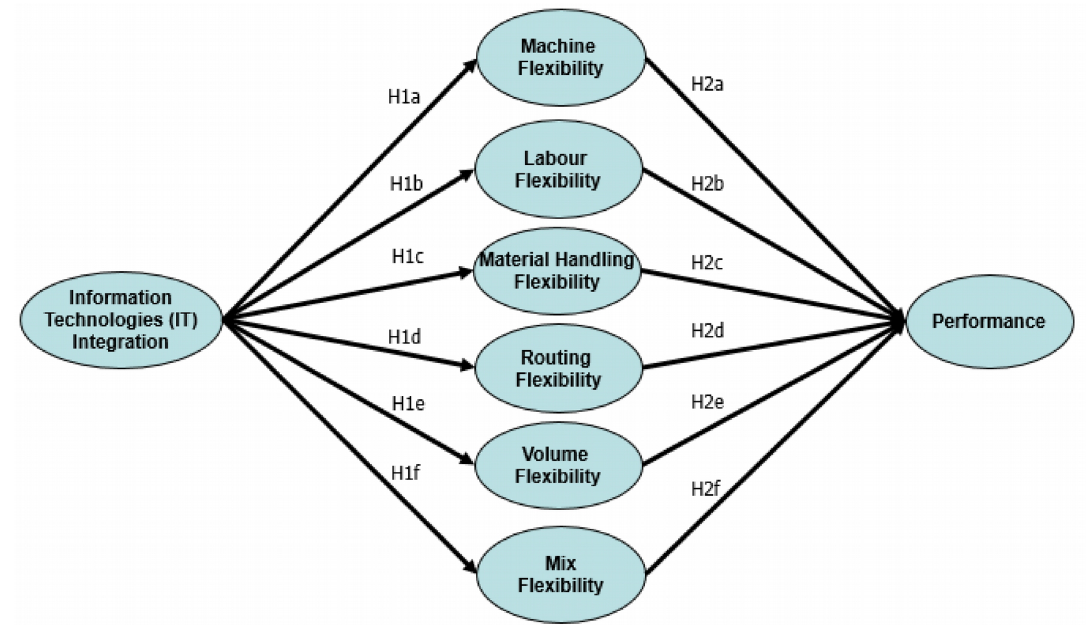
Figure 1. Conceptual